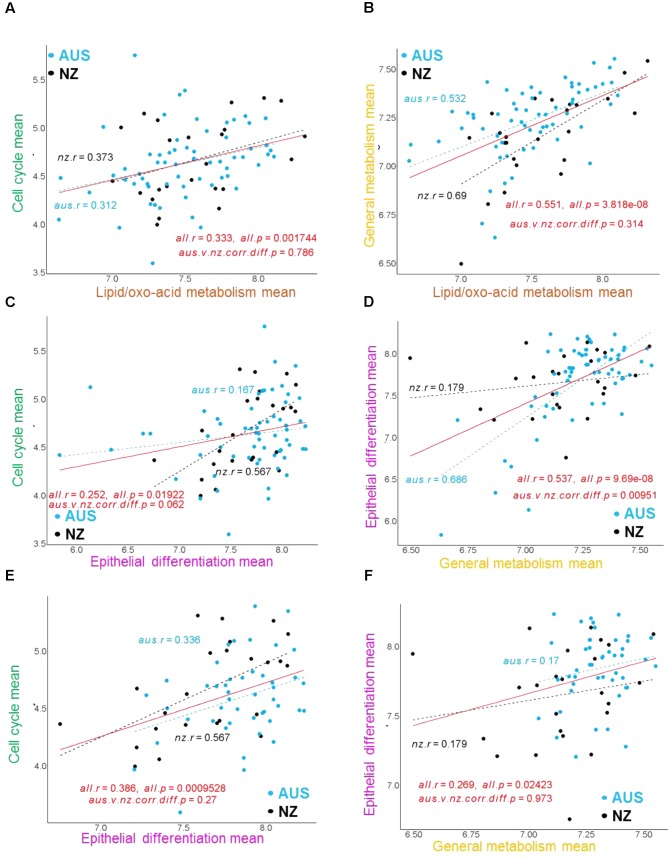
Examples of correlation regressions between the mean expression of major gene clusters in the AUS and NZ datasets. The correlations and significance of between-experiment difference in correlations for mean gene cluster expressions are indicated for each analysis on the relevant panel. The mean expression of the set of genes in each gene cluster for each animal was calculated from the voom (Law et al., 2014) normalized gene expression values for each gene in each animal generated by normalizing the AUS and NZ datasets together. Quantile normalization was used to remove non-biological variations (Bolstad et al., 2003). (A–D) Correlation regressions with all AUS animals included in the analysis. (E,F) Correlation regressions without the AUS block 1 animals.